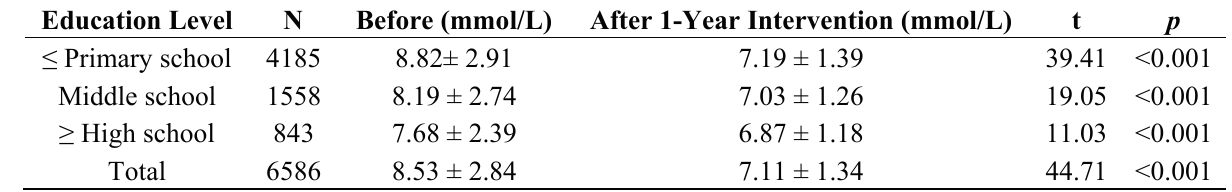
Table 6. Changes of participants’ FPG according to education level (Mean ±